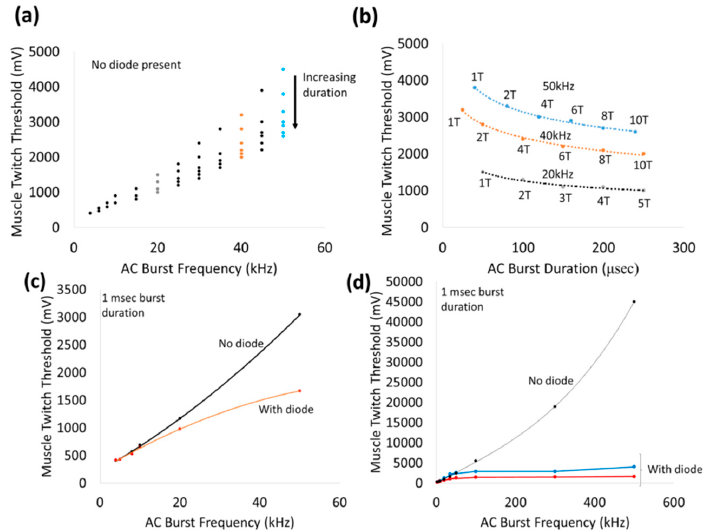
Figure 8. Representative stimulus voltage thresholds for different frequencies of AC stimulation. ( a ) and ( b ) show that the stimulus voltage threshold is dependent on the AC frequency and the burst duration, which is generated by variation in the number of periods (T) or full cycles as seen for 20, 40, and 50 kHz in ( b ). At 20 kHz, increasing burst duration from 50 µsec (1 T) to 1 msec ( c ) decreased the threshold stimulus by 45–55%. The trends observed in the curves in ( b ) are best fit to a power relationship (R 2 > 0.99). ( c ) The presence of the diode decreases stimulus voltage threshold in a frequency-dependent manner ( ≥ 20 kHz). At higher frequencies ( d ), the stimulus voltage threshold increases non-linearly with the input AC frequency in the absence of a diode. The blue (forward bias away from cathode) and red (forward bias toward cathode) lines indicate the presence of a diode in two different orientations.